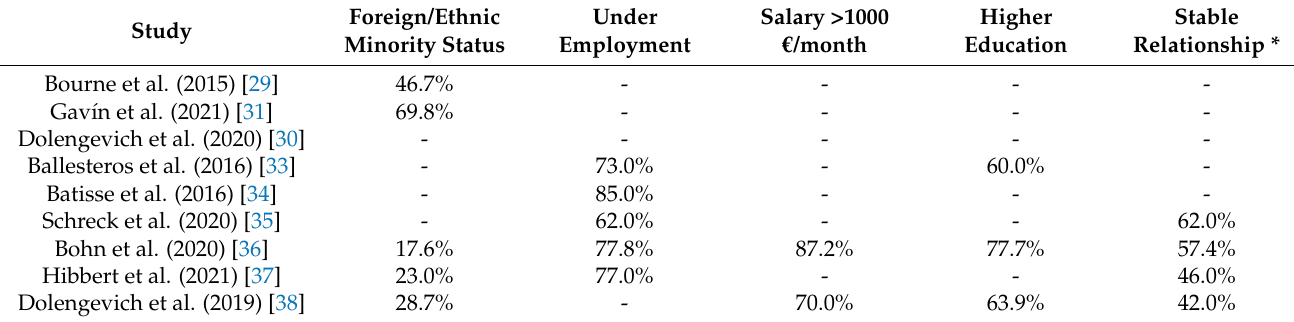
Table 3. Sociodemographic characteristics of the populations of the included